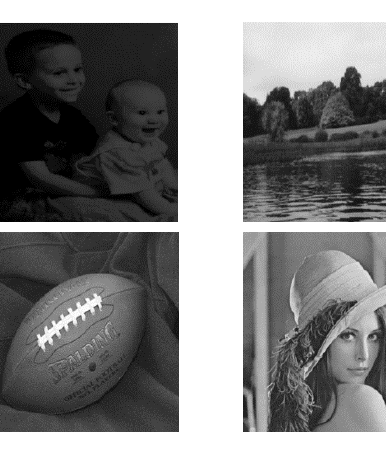
Figure 11. Standard benchmark images used in the proposed method.